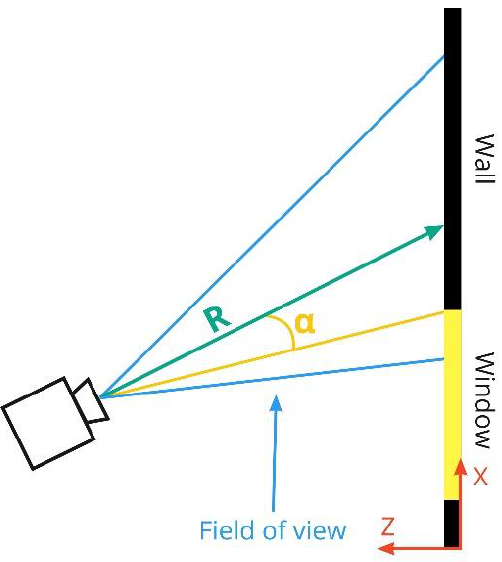
Figure 6. Modeling the calculation of camera highlights.